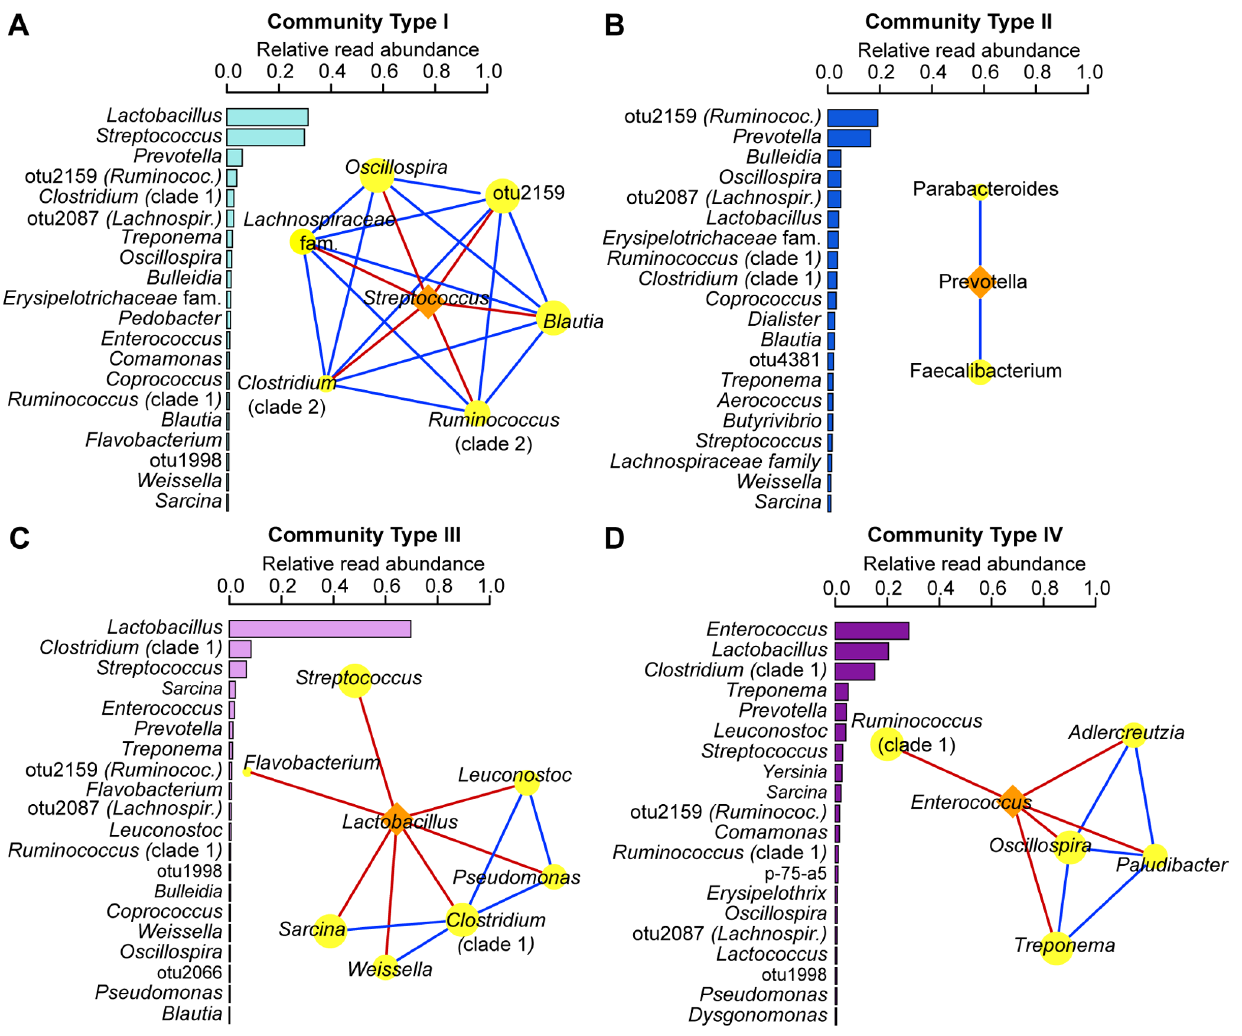
Figure 4. Composition of community types in the cynomolgus macaque fecal microbiota. ( A to D ) Rank abundance plots (left) and correlation networks (right) for community types I–IV. For rank abundance plots, the most abundant genera are shown on the y-axis and its relative read abundance is shown on the x-axis, calculated within each community group. Correlation networks were calculated using a Spearman rank correlation coefficient (P , 0.001) for the most abundant (pivotal) genera within each community type. Sub-networks (modules) for directly connective genera were identified for each pivotal genera. For each module, the orange diamond vertex indicates the main contributor and yellow ellipse vertices co-occurring genera. Blue and red lines indicate positive and negative correlations, respectively.